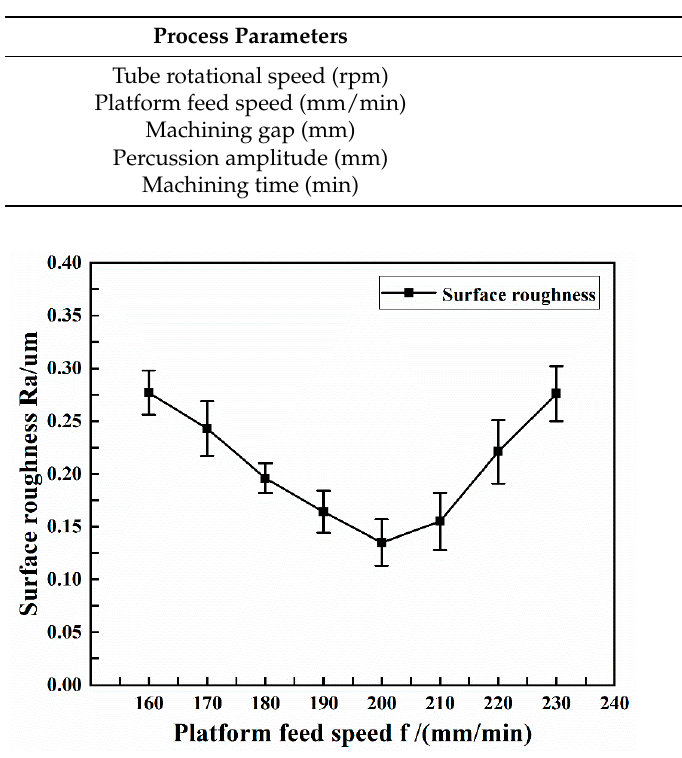
Figure 9. Effect of platform feed speed on surface roughness.